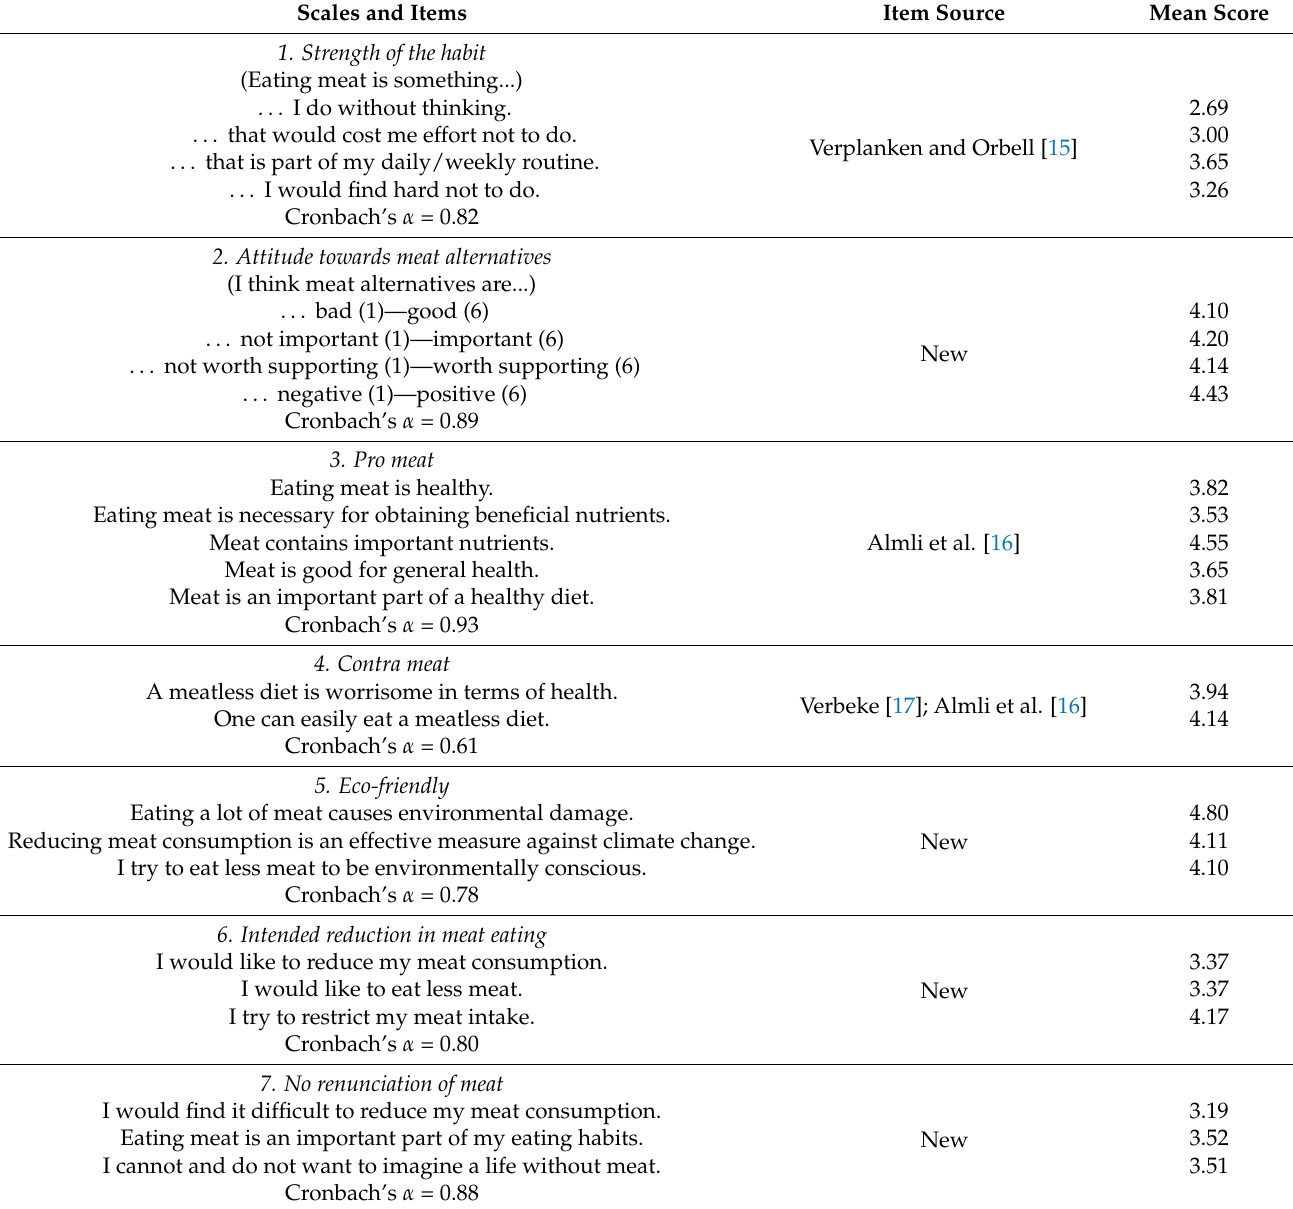
Table 1. Scales, items (including their source(s)), means, and reliability scores. Scales and Items Item Source Mean